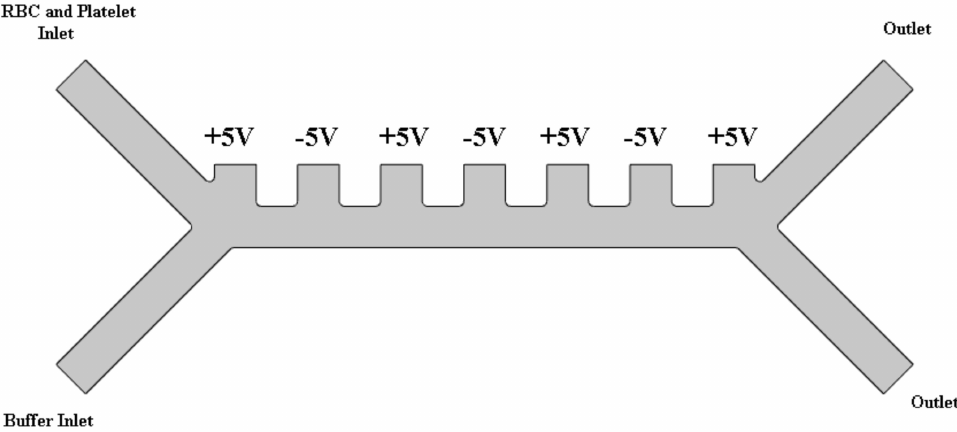
Figure 4. Simple square in fluid electrode microfluidic